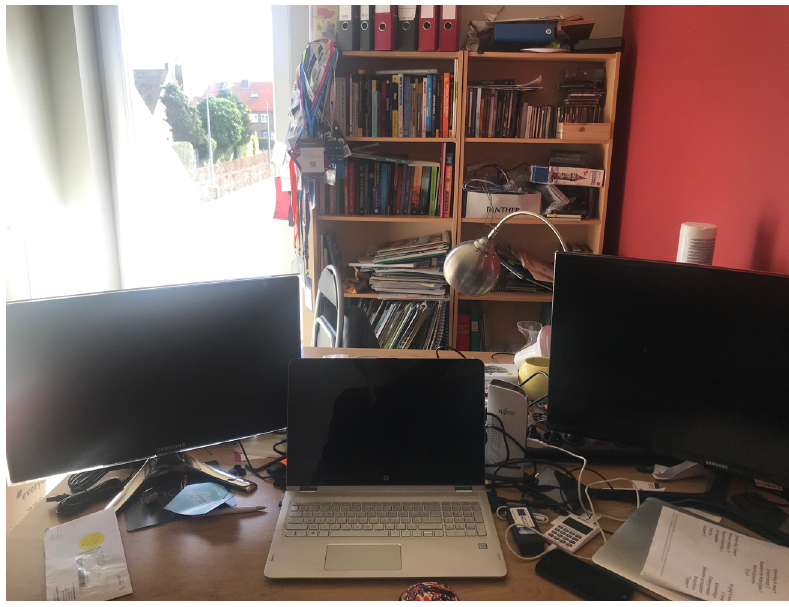
FIG. 7 Large desk with three screens and dark red color for home-office in Steve’s